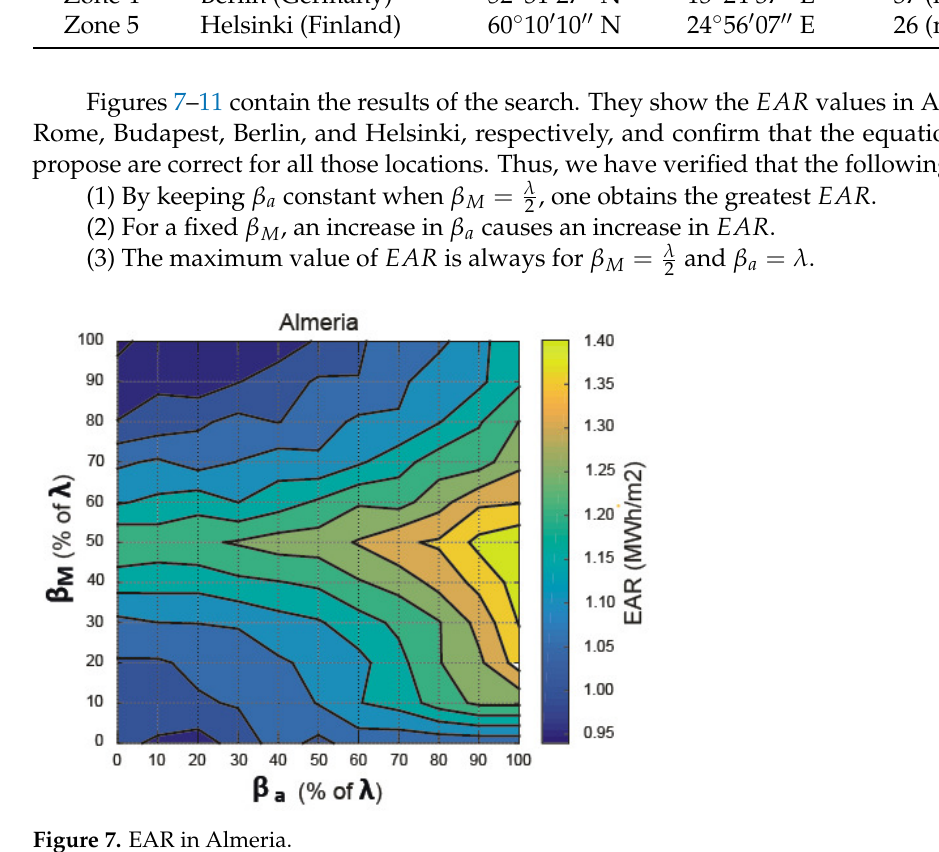
Figure 7. EAR in Almeria.